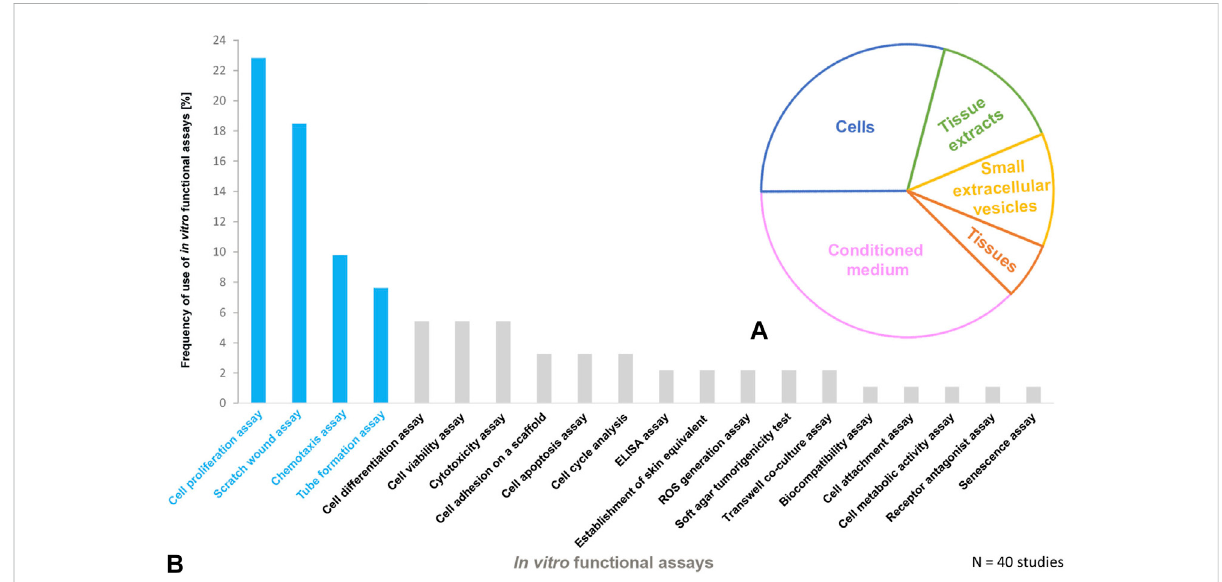
FIGURE 1 Perinatal derivatives and in vitro functional assays used for cutaneous wound healing in animals (A) The schematic presentation of PnD functionally tested in vitro and (B) frequency of use of in vitro functional assays in animal studies of cutaneous wound healing. The most frequently used functional assays are highlighted in